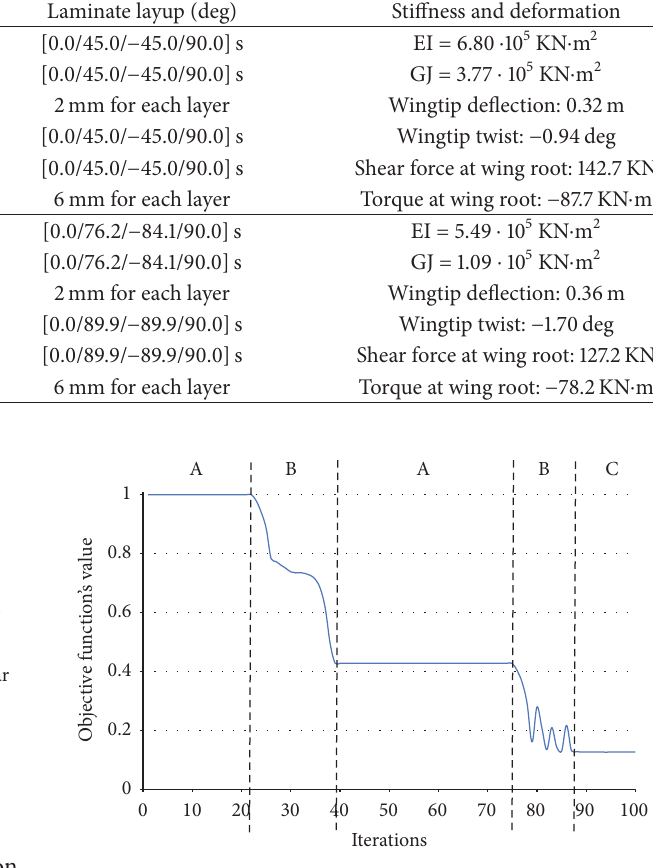
Figure 6: The optimization process using gradient-based determin- istic